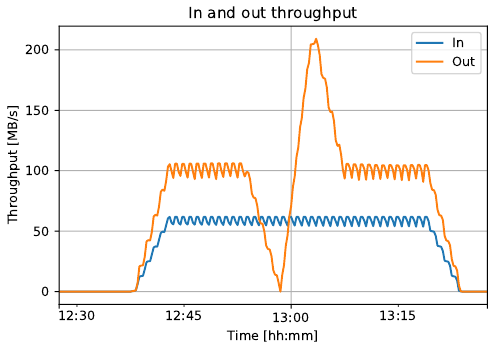
Figure 6. Kafka queue, throughput measurement: in blue the messages coming inside the queue, in orange the ones going out. From this plot it is visible that producers input messages constantly for the entire test while the consumer stops for 5 minutes dropping the output throughput. Once the consumer is back its throughput increases way above the normal level in order to catch-up the producers. Once the queue is emptied, the output throughput goes down to the same level as the one at the beginning of the test. Also in this case, the di ff erence between the input and output throughput is due to protocol overhead and it is under investigation. During this test, 105 producers and a single consumer were